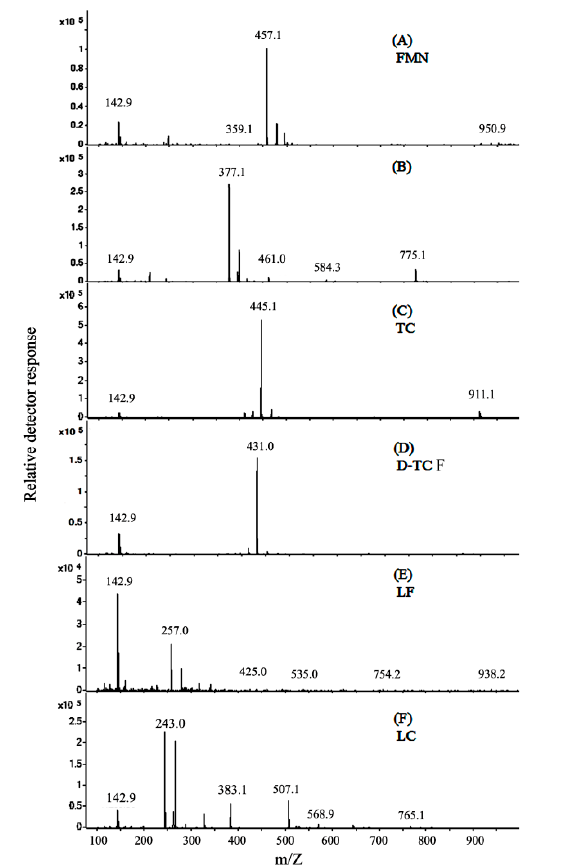
Figure 8. Spectra of ( A ) FMN, ( B ) riboflavin, ( C ) TC, ( D ) D-TCF, ( E ) lumiflavin, and ( F ) lumichrome from the TC treated with FMN under blue light irradiation for 1 h. The ionic spectral product of [M+H] + is considered to be blue light-altered TC in solution (pH 7.8). The precursor ion of m/z 445 was selected, and the proposed fragments are shown in each spectrum.